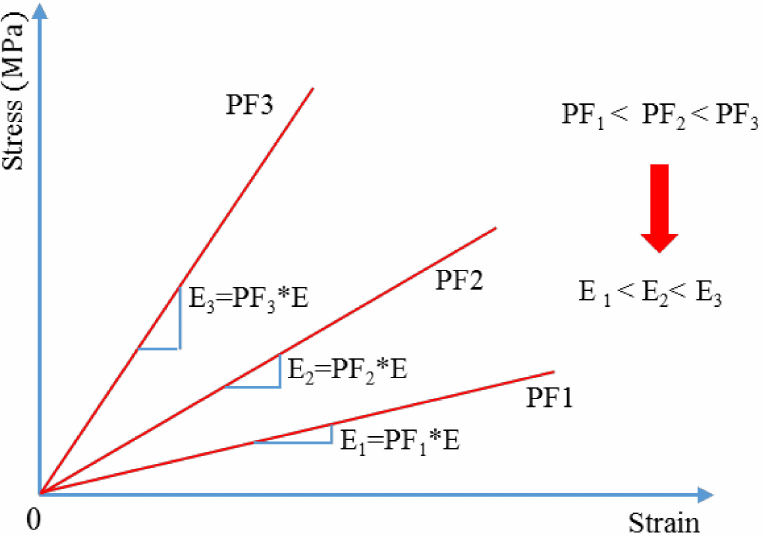
Figure 3. Effect of packing factor ( PF ) on the modulus of the